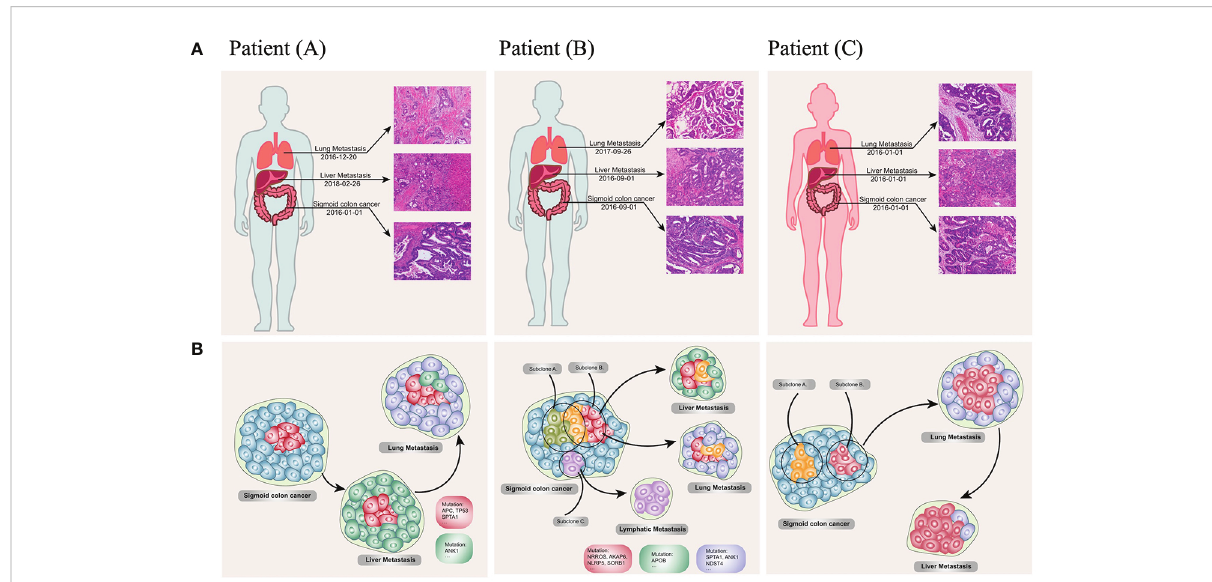
FIGURE 6 Clinical, pathological (A) and phylogenetic tree (B) of the three multiorgan metastatic patients. (A) Representative H&E-stained histological sections of primary colon cancer, lymph node, liver metastases, and lung metastases. (10 × 20 magni fi cation). Patient (A) developed synchronous liver metastases at the diagnosis of the sigmoid colon cancer and revealed lung metastases one year after the resection of colonic and hepatic lesions; patient (B) reported lung lesion one year after the initial Dixon surgery, and intrahepatic metastases after the pulmonary lobectomy; patient (C) presented synchronous liver and lung metastases at her initial diagnosis. (B) The original subclone (red cells and cyan cells) contains driver mutations (TP53, APC, KRAS), which remain unchanged during the disease course. Novel mutations in the hepatic (green cells) and pneumonic (blue cells) metastases could pass on to the other site of metastases according to their expansion process. Lymphatic metastases seed from a distinct subpopulation of primary tumor (purple cells). Reconstructed cancer phylogenies demonstrate patient (A) . Original colon cancer seeds liver metastases, which in turn leads to subsequent lung lesion; patient (B) . a small genetic variant from subclone A to subclone B give rise to independent metastases to the liver and lung, while a distinct subclone in the primary tumor moves to the reginal lymph node; patient (C) heterogeneity exists in the primary colon tumor, one of the subclone seeds the lung nodule before it evolves to the